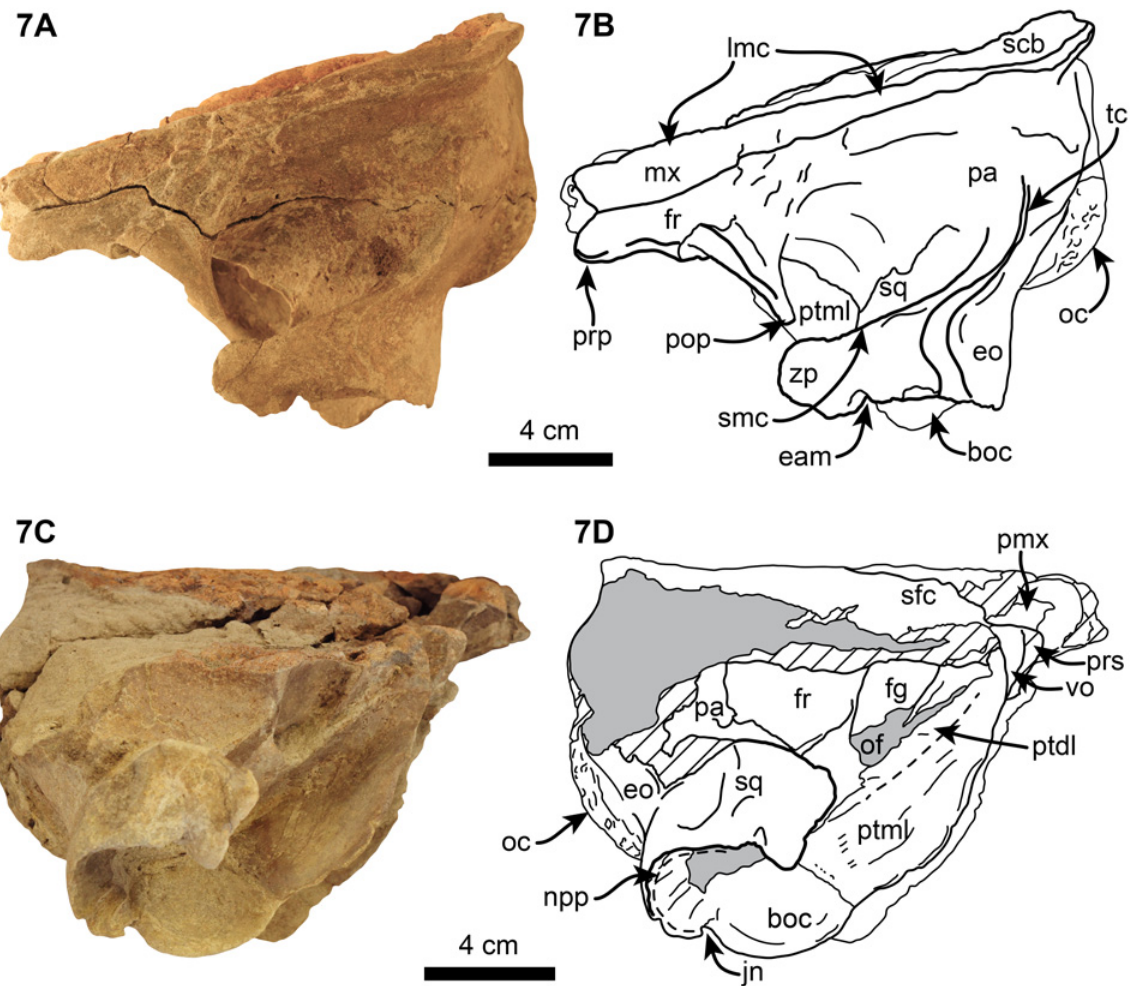
Fig 7. Left, 6A-B, and right, 6C-D, lateral views of referred specimen of Nanokogia isthmia gen. et sp. nov. (UF 273554). Abbreviations: boc, basioccipital crest; eam, external auditory meatus; eo, exoccipital; fr, frontal; lmc, lateral maxillary crest; mx, maxilla; npp, notch for posterior process of tympanic; oc, occipital condyle; of, optic foramen; pa, parietal; pmx, premaxilla; pop, postorbital process; prp, preorbital process; prs, presphenoid; ptdl, dorsal lamina of pterygoid; ptml, medial lamina of pterygoid; scb, supracranial basin; smc, supramastoid crest; sq, squamosal; tc, temporal crest; vo, vomer; zp, zygomatic process. Gray shaded areas indicate sediment; diagonal lines denote broken